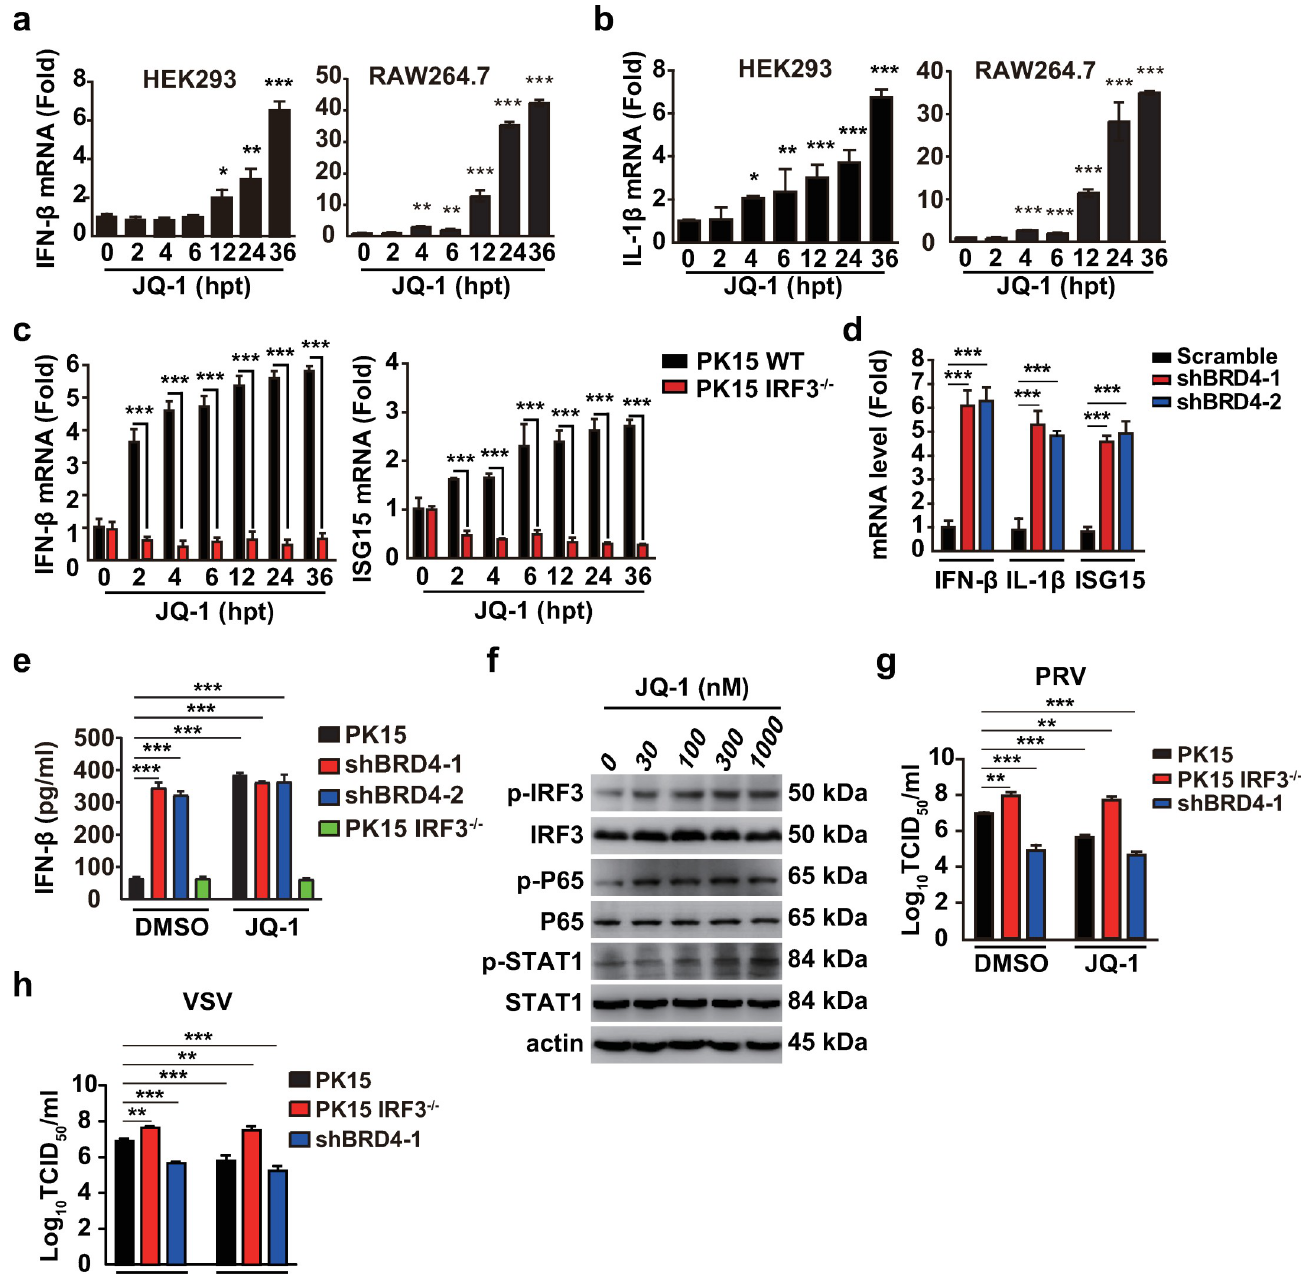
Fig 6. BRD4 inhibition activates antiviral innate immune responses. (a and b) IFN- β (a) and IL-1 β (b) mRNA was assessed with RT-qPCR analysis in HEK293 and RAW264.7 cells treated with JQ-1 (1 μ M) at 0, 2, 4, 6, 12, 24 and 36 hpt. (c) IFN- β and ISG15 mRNA were assessed with RT-qPCR analysis in PK15 and IRF − / − cells treated as in a. (d) IFN- β , IL-1 β and ISG15 mRNA were assessed with RT-qPCR analysis in Scramble, shBRD4-1 and shBRD4-2 PK15 cells. (e) IFN- β was quantified by ELISA in PK15, IRF3 − / − , shBRD4-1 and shBRD4-2 cells treated with DMSO or JQ-1 (1 μ M) for 24 h. (f) Phospho-IRF3, phospho-P65, phospho- STAT1, total IRF3, P65 and STAT1 were assessed with immunoblotting analysis in HEK293 cells treated with DMSO and JQ-1 (0–1000 nM) for 24 h. Actin served as a loading control. (g and h) Viral titer was assessed with TCID 50 assays in PK15, IRF3 − / − and shBRD4-1 cells infected with PRV-QXX (g, MOI = 0.1) or VSV-GFP (h, MOI = 0.001) and treated with DMSO or JQ-1 (1 μ M) for 24 h. All data are shown as mean ± SD based on three independent experiments. � P < 0.05, �� P < 0.01, ��� P < 0.001 determined by two-tailed Student’s t -test.